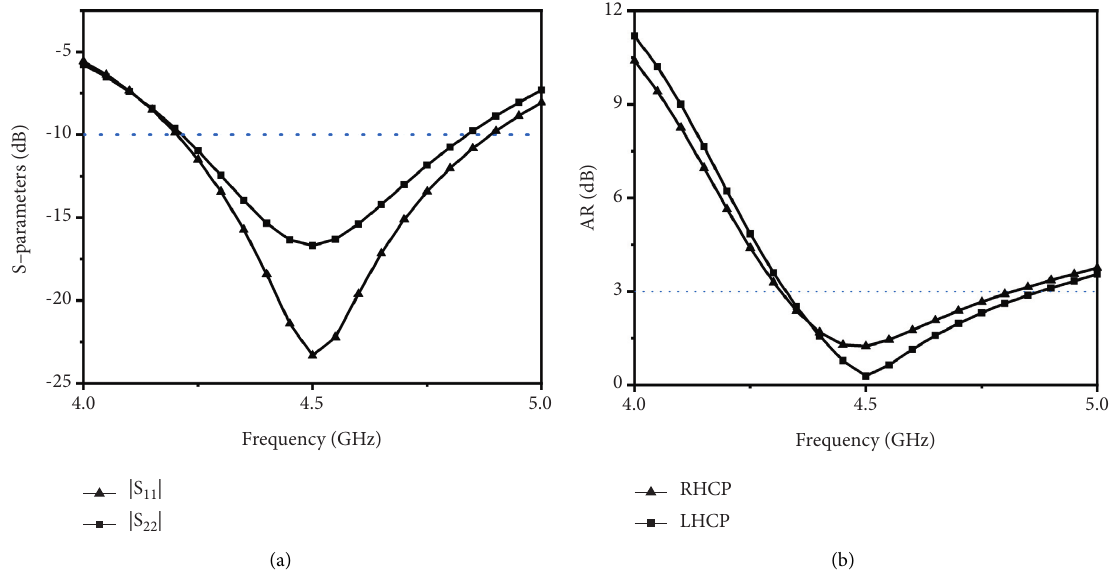
Figure 4: The simulation results. (a) Simulated S-parameters. (b) AR.